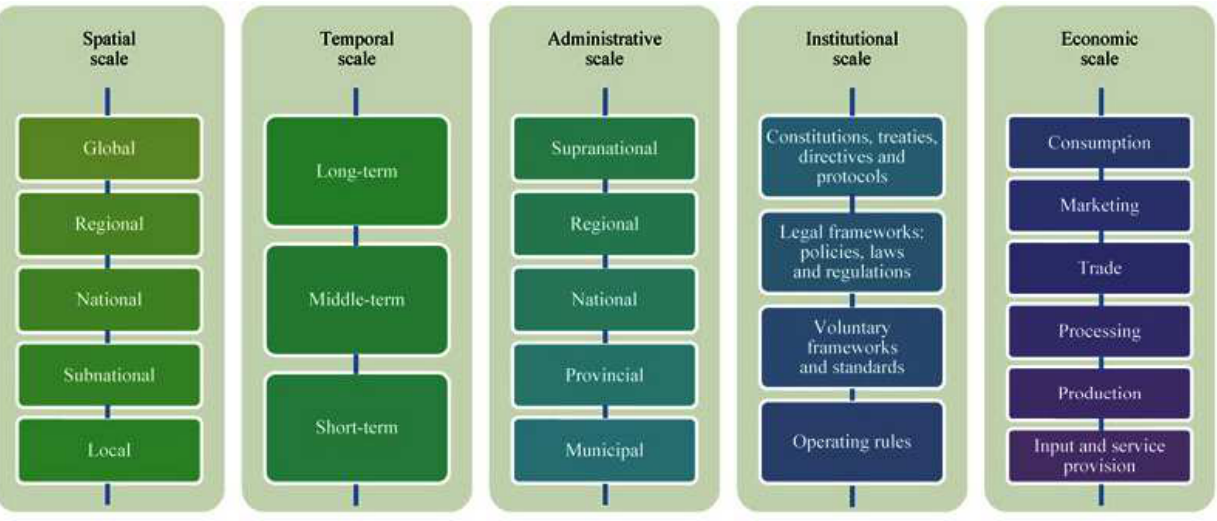
Fig. 1. Examples of scales and